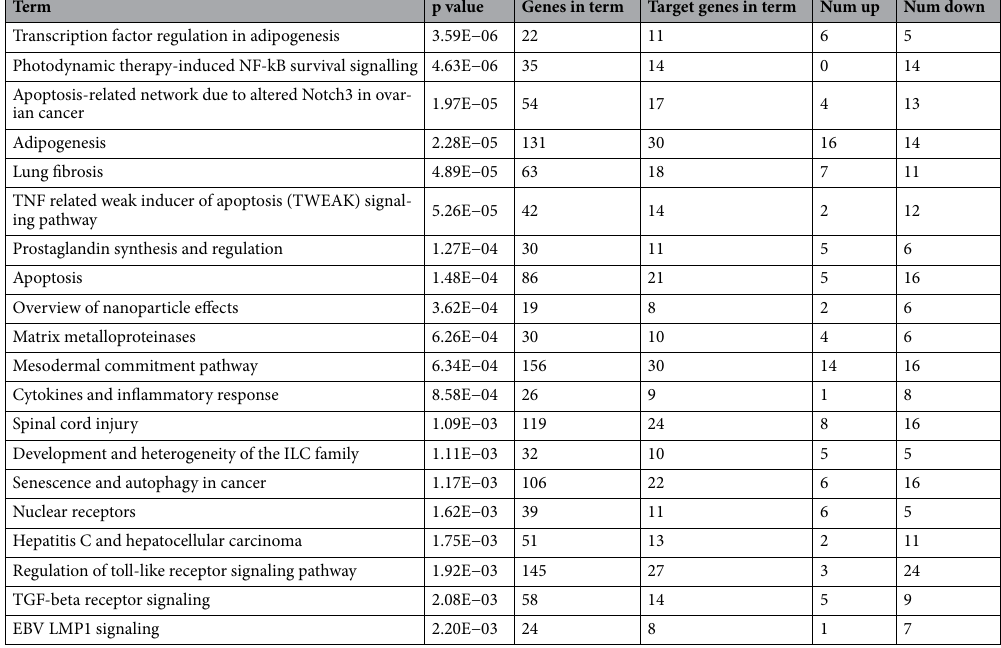
Table 1. Twenty pathways with the lowest p-values, according to WikiPathways, including pathways related to adipogenesis, inflammation, fibrosis, extracellular matrix metabolism, and TGF-β receptor signaling.